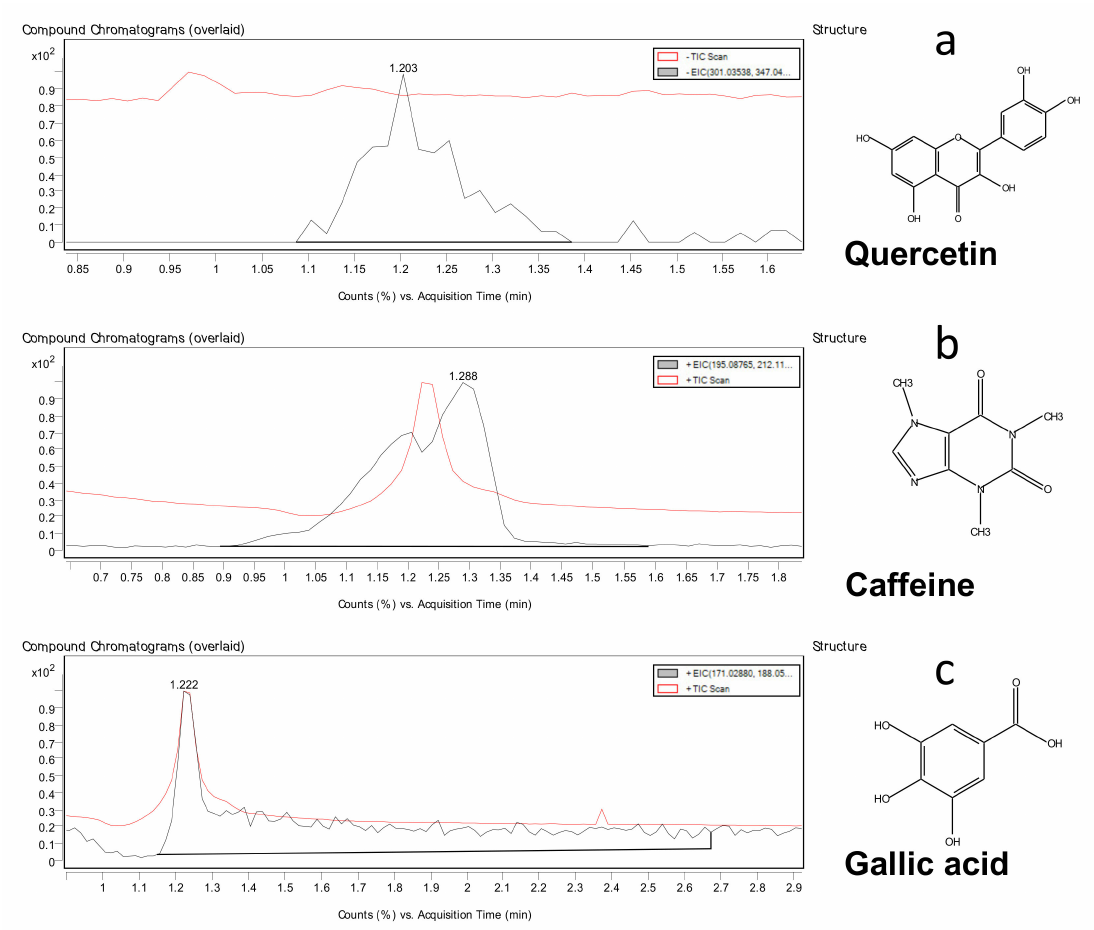
Figure 2. The quadrupole time-of-flight mass chromatograms with the EIC and +TIC scan of the polyphenols in crude methanol fraction of the coffee pulp powder with the chemical structures ( a ) quercetin, ( b ) caffeine and ( c ) gallic acid.